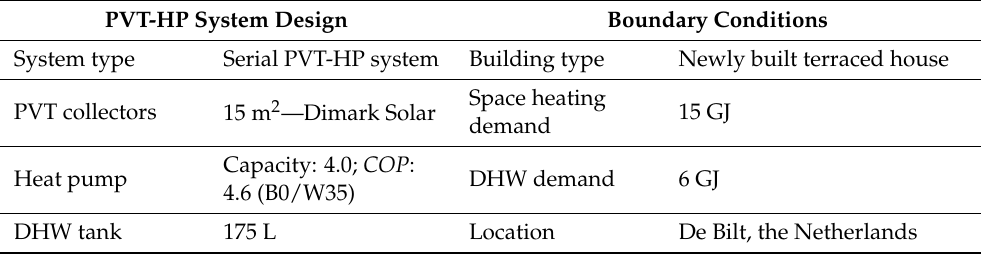
Table 13. Key features of the designed PVT-HP system and the boundary conditions of the reference